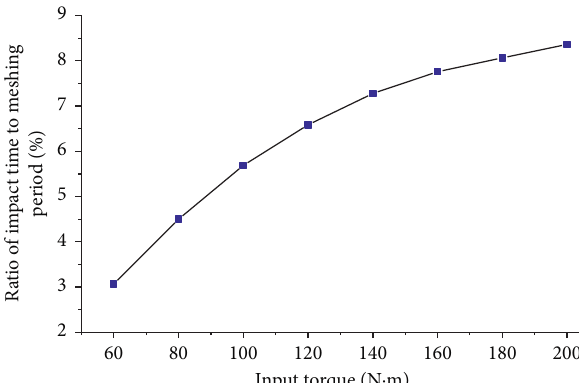
Figure 6: The change of meshing impact time with